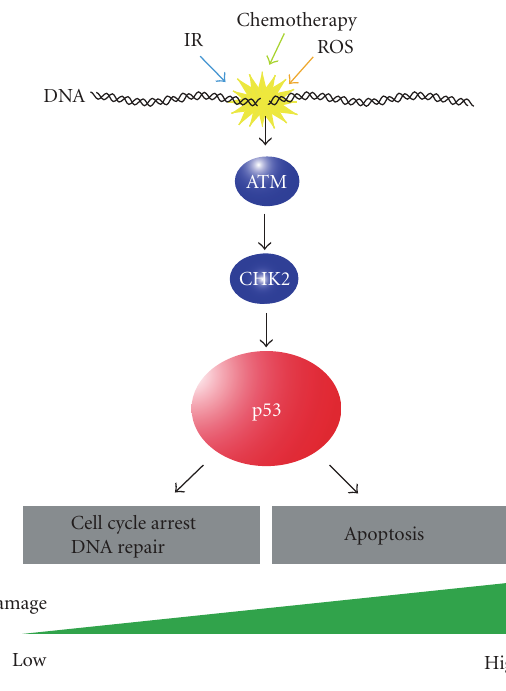
Figure 1: Functions of p53 in response to DNA damage. Genomic stresses caused by ionizing radiation (IR), chemotherapy, and reactive oxygen species (ROS) activate DNA damage check point pathway, which leads to the activation of ATM and CHK2 and sub- sequent stabilization of p53. Then, stabilized p53 induces cell cycle arrest and DNA repair when DNA damage is moderate, whereas it activates apoptosis pathway when DNA damage is extensive.